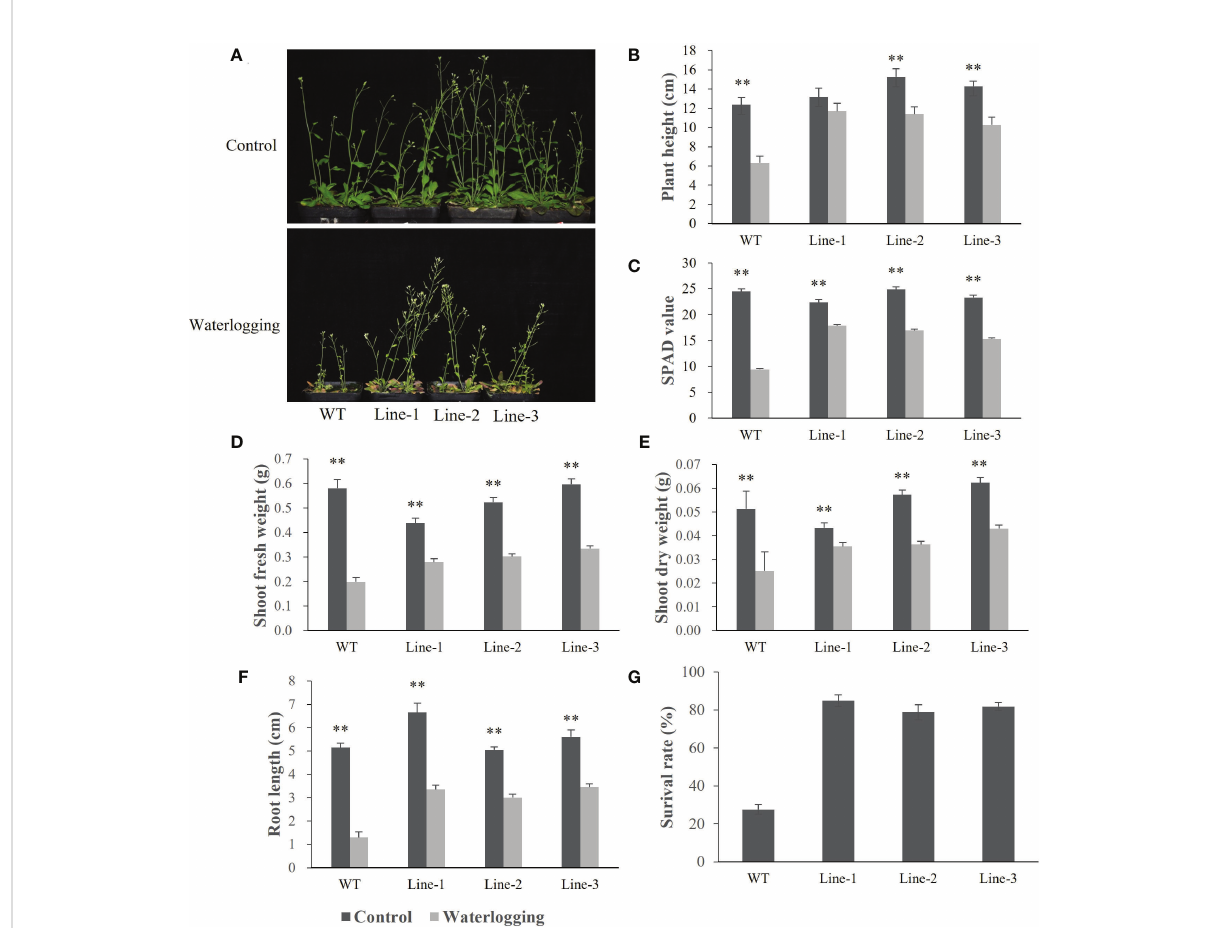
FIGURE 6 Waterlogging tolerance assay of HvERF1 overexpression lines (Line1, Line2, Line 3) and wild-type (WT). (A) Five week-old plants were subjected to waterlogging stress for further 2 weeks. (B) Plant height. (C) Soil-plant analysis development (SPAD) value (based on chlorophyll meter reading). (D) Shoot fresh weight. (E) Shoot dry weight. (F) Root length. (G) Surival rate in the wild-type and HvERF1 transgenic lines were measured under control and waterlogging stress. Values are the means ± SD. Means were generated from three independent measurements. Data were analyzed by one-way analysis of variance followed by Duncan ’ s test. “ ** ” means a signi fi cant difference at the P < 0.01